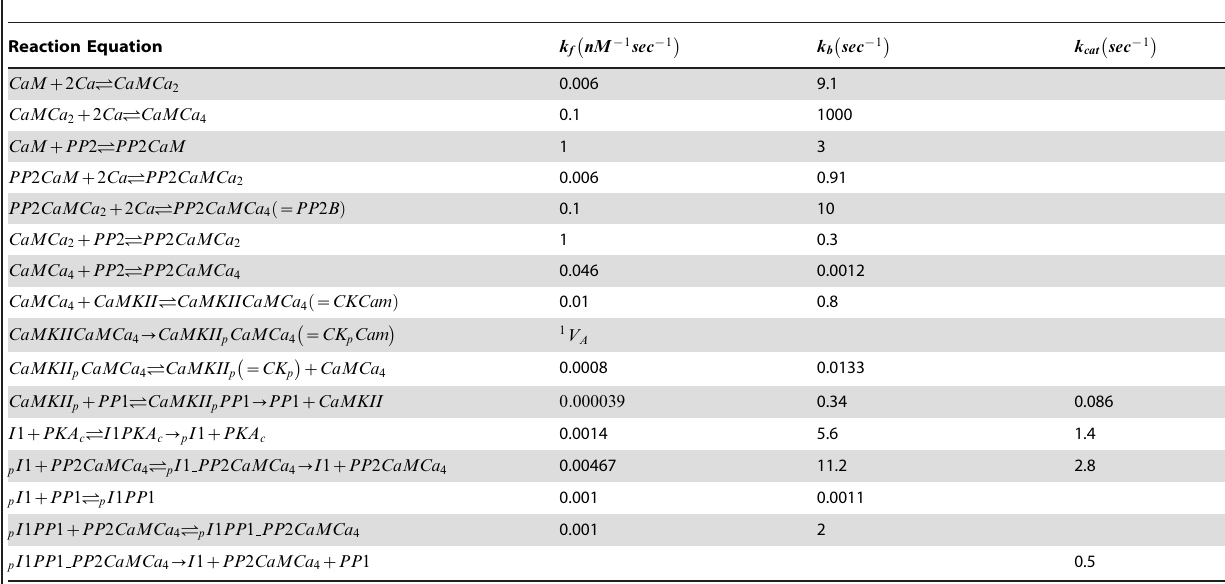
Table 2. Reactions and rate constants involved in signaling pathways from calcium to CaMKII and PP2B.